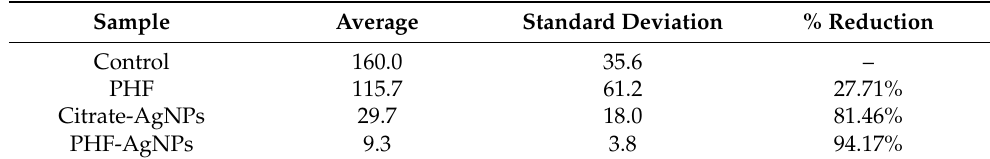
Table 1. Summary data of essays of antibacterial activity of control, PHF, citrate-AgNPs, and PHF- AgNPs against E. coli. Data corresponds to E. coli counts, in colony-forming units (cfu).